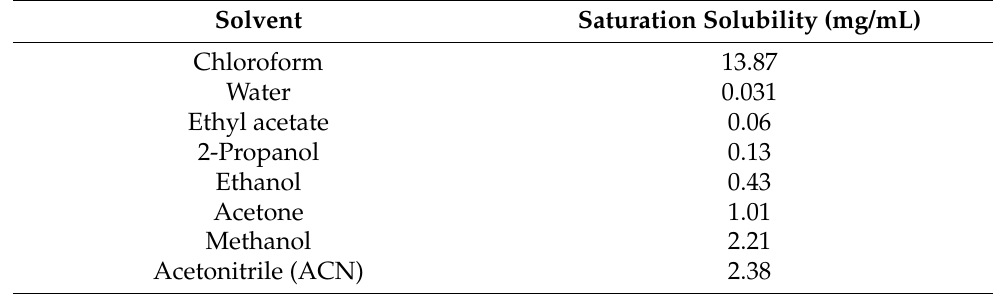
Table 2. Saturation solubility of APX in organic